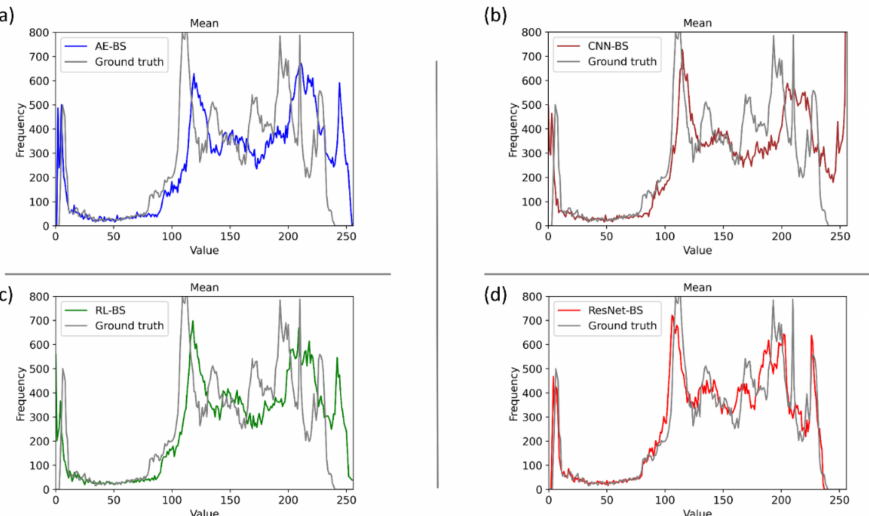
Figure 6. Comparing the histogram of the predicted image using the proposed bone suppression models and the ground truth using the sample CXR from Figure 2. ( a ) Ground truth and AE–BS model; ( b ) Ground truth and CNN–BS model; ( c ) Ground truth and RL–BS model; and ( d ) Ground truth and ResNet–BS